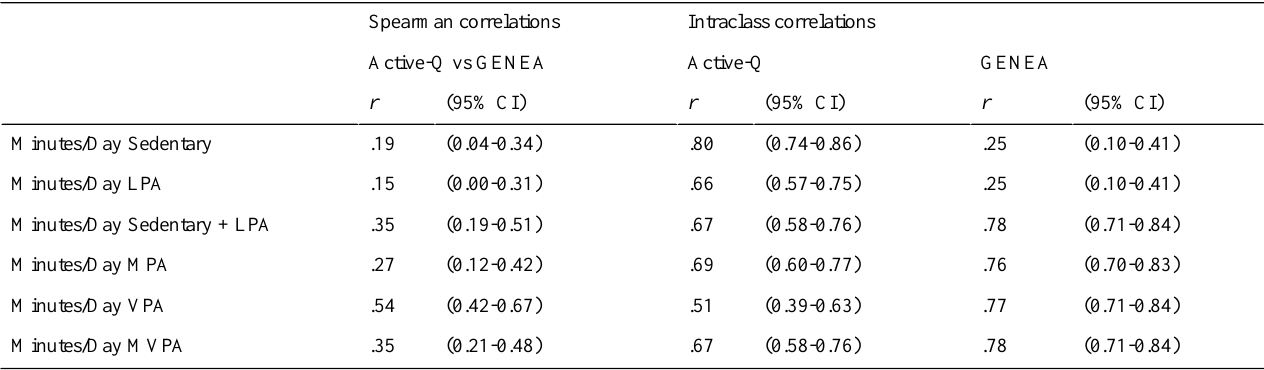
Table 4. Spearman correlation coefficients between time at different intensity levels and total MET-h in the first Active-Q questionnaire and time and total SVMgs from GENEA measurements during 12 days (n=148) and Intraclass correlation coefficients between the two Active-Q questionniares administered and between the two weeks of GENEA measurements (n=148).